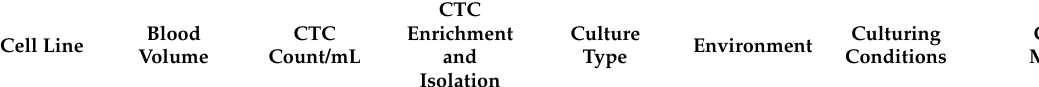
Table 2. Culture protocols of CTC cell